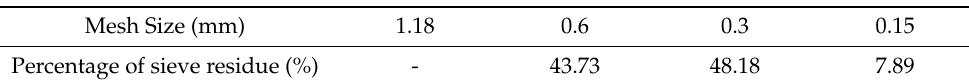
Table 2. Sieve analysis result of